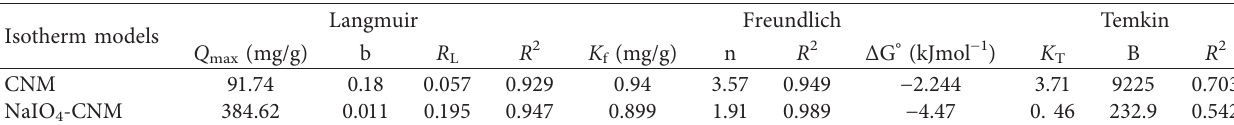
℃ . 4 -CNM sorbent at 25